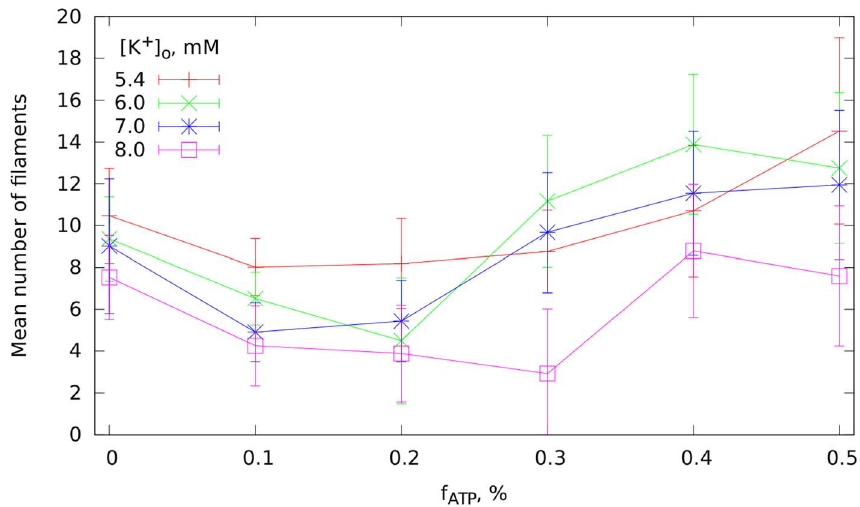
Figure 9. The mean number of filaments of a fibrillation pattern averaged over time of simulation after applying ischemic conditions. The error bars indicate the standard deviation of root mean square.